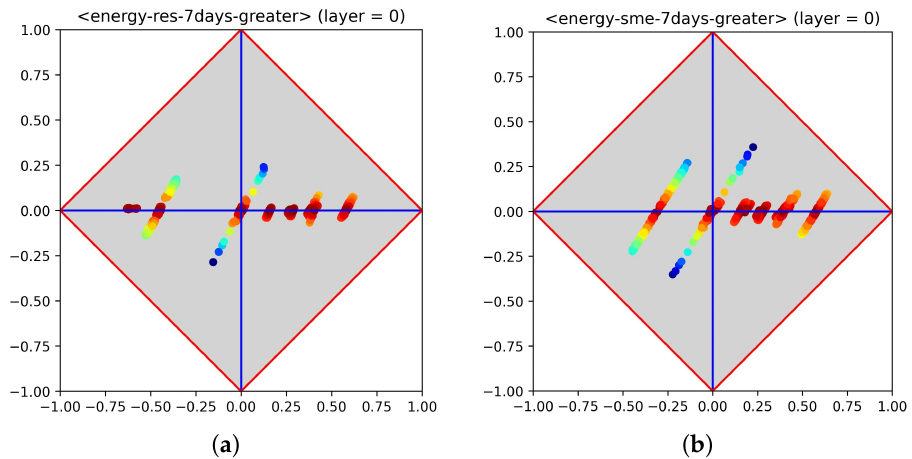
Figure 3. Class signatures of the datasets relating to residential loads ( a ) and enterprise loads ( b ). The reported signatures regard the greater-vs-rest binarization over the full set of features. ( a ) Loads of residential customers. ( b ) Loads of enterprise customers.